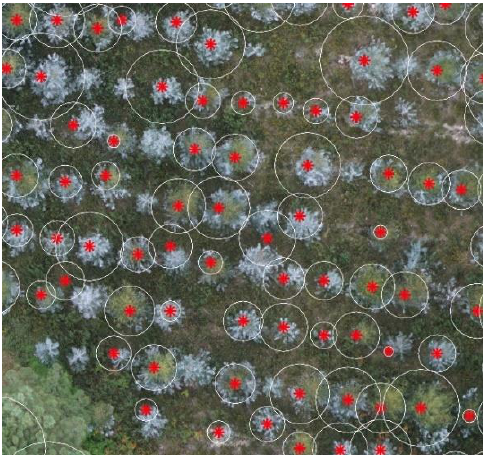
Figure 10. Trees identified in Dataset 3, with the estimated crown diameters. Trees are represented by red dots.